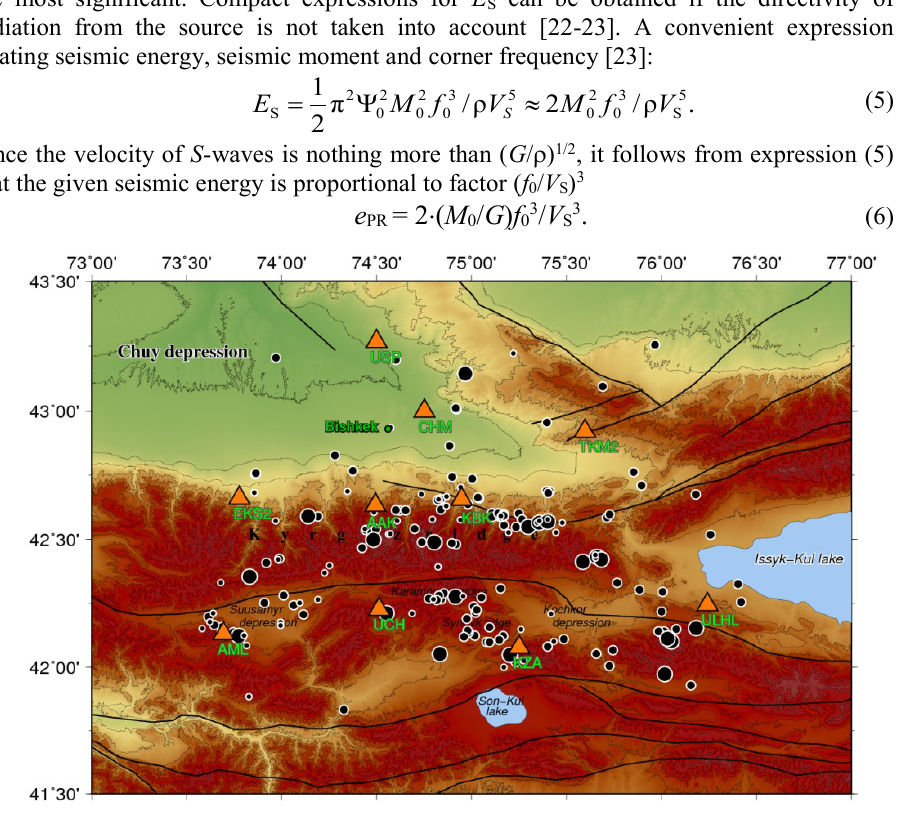
Fig. 3. Earthquakes epicentral location of (183 events).The minimum circle corresponds to the event with М = 2.7, the maximum - with М = 6.0 Triangles - KNET stations location. Black lines are regional